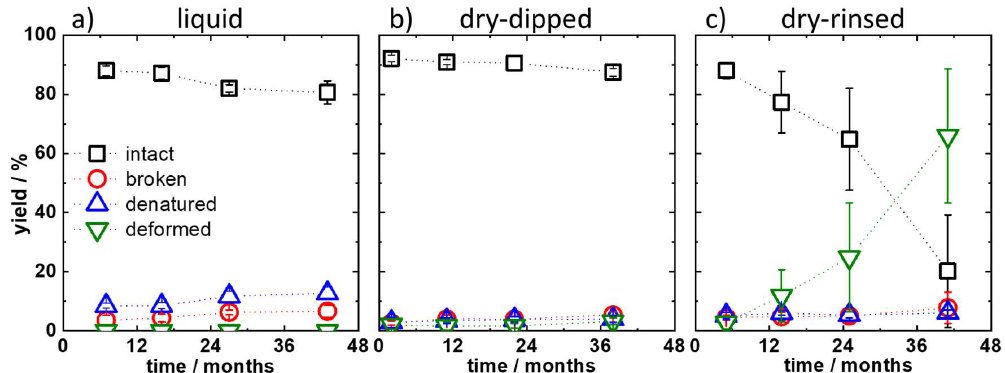
Figure 3. Yields of intact, broken, denatured, and deformed DNA origami depending on the age of the staple solution for ( a ) measurements in liquid, ( b ) measurements using the dry-dipped protocol, and ( c ) measurements using the dry-rinsed protocol.